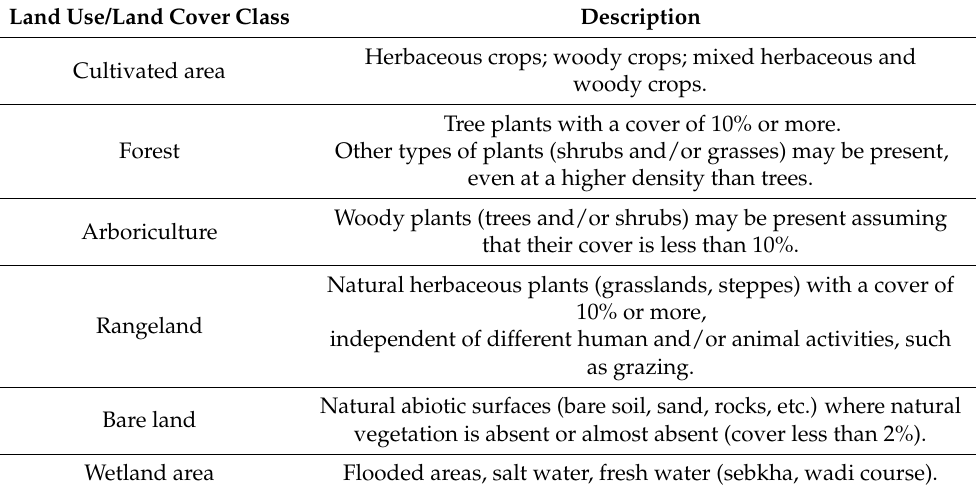
Table 1. Different classes adopted for the diachronic study of land use degradation [29]. Land Use/Land Cover